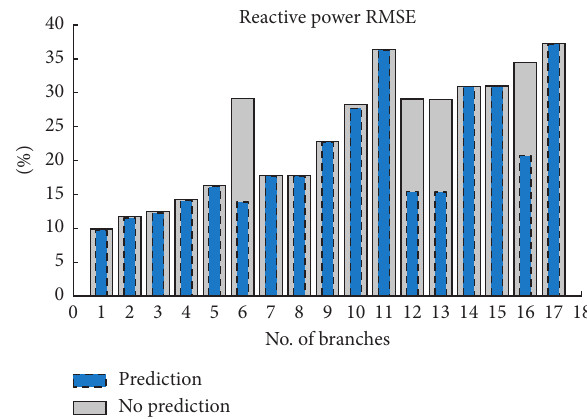
Figure 13: Reactive power RMSEs obtained with and without the ANN-based